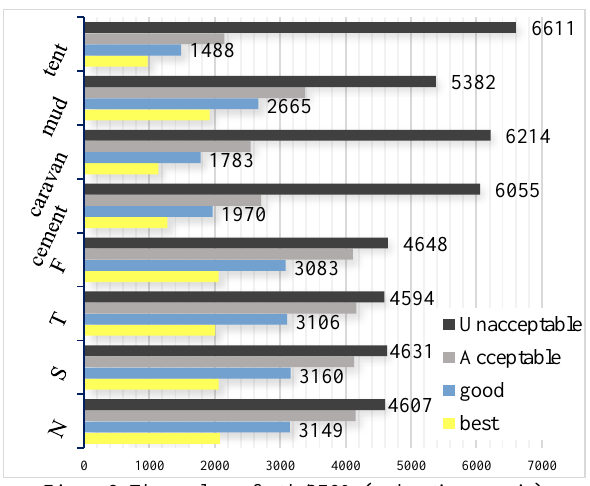
Figure 8. Thermal comfort h/8760, (authentic scenario).